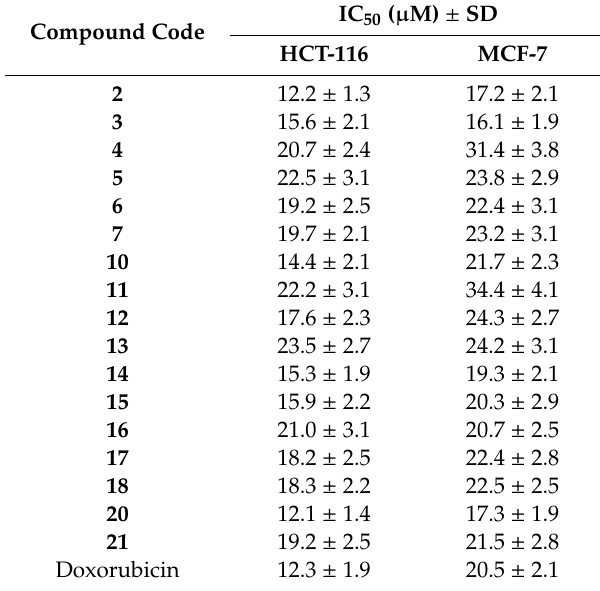
Figure 3. Dose dependent cytotoxic activities of the compounds against MCF-7 cancer cells according to the MTT assay. Table 1. IC 50 of the compounds against the two cancer cell lines according to the MTT assay.